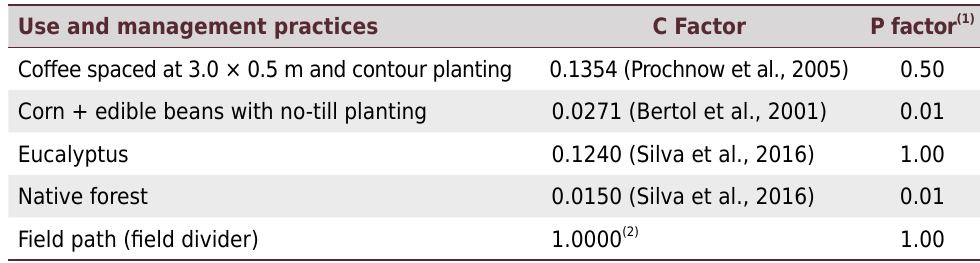
Table 2. The C and P factors for uses and management practices